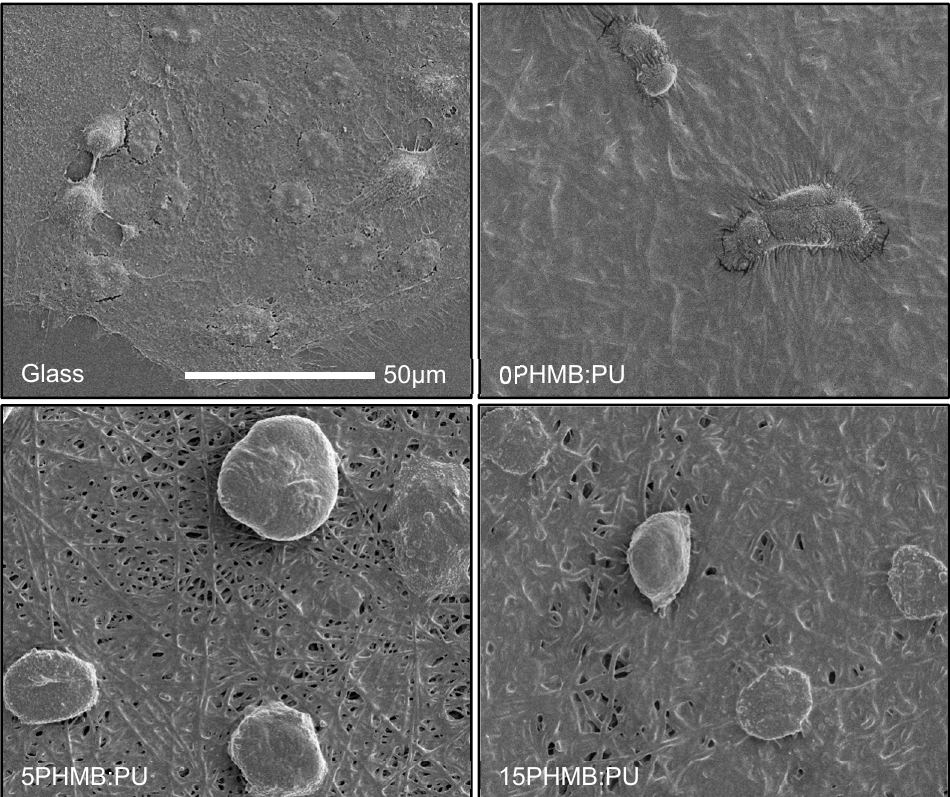
Figure 11. HaCaT cell morphology on PHMB:PU membranes. SEM images showing cell morphology after 48 h on membranes which had been immersed in cell culture media overnight before cell seeding to mimic attachment after use in vivo.